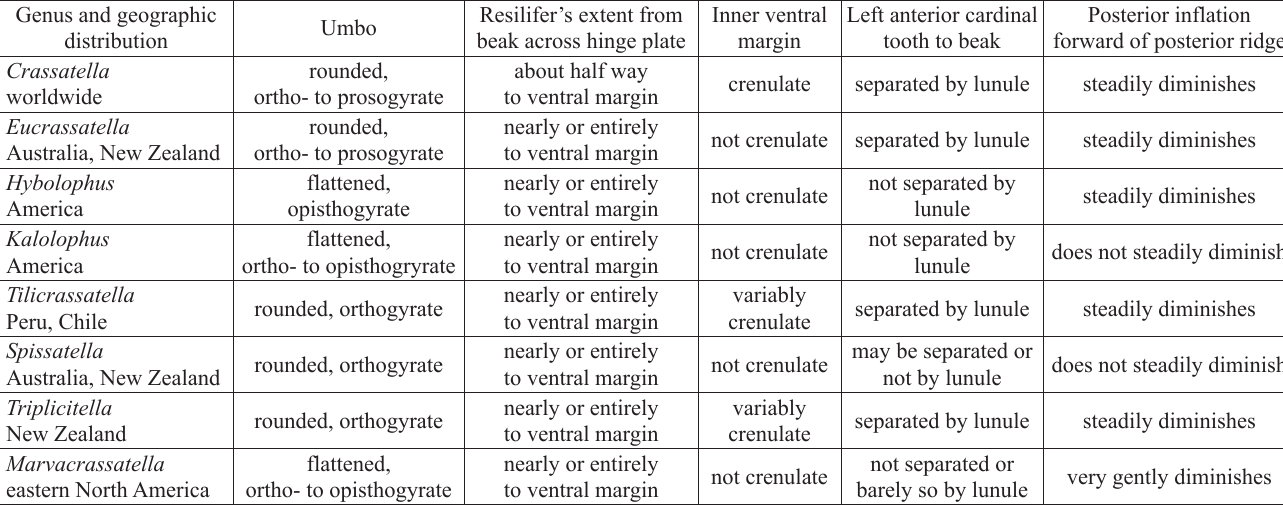
Table 1. Generic characteristics of large crassatellines from Australia, New Zealand, and North and South America. Genus and